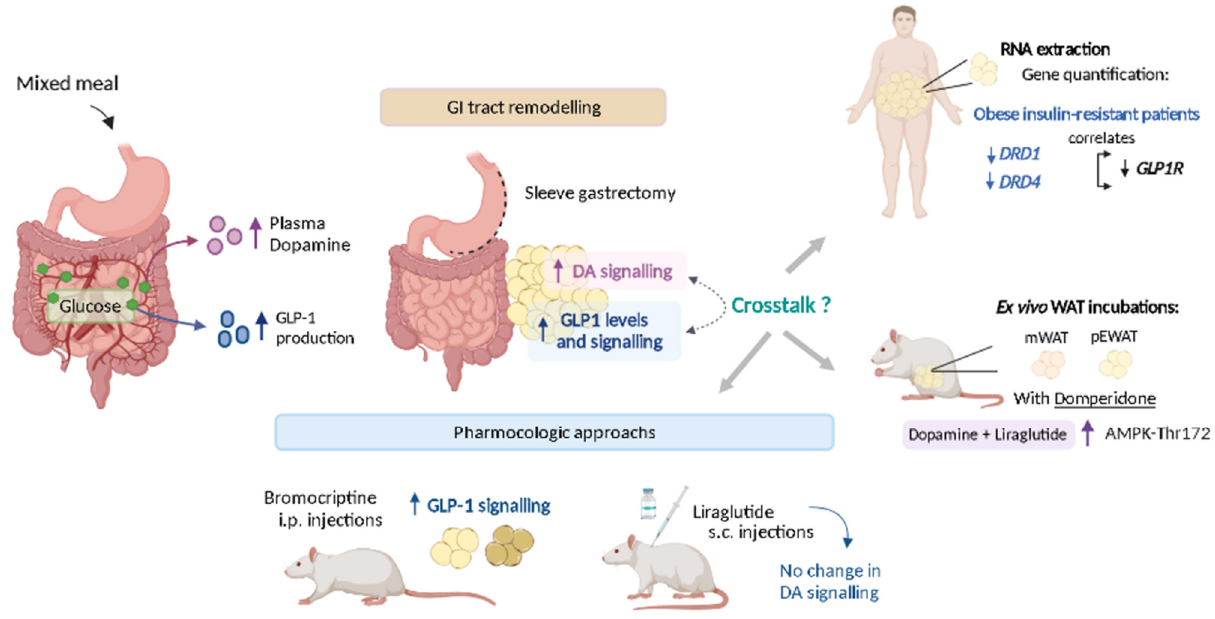
Figure 7. Summary figure of relevant findings. Plasma dopamine levels are postprandially elicited by dietary glucose, and its action in WAT is regulated by the gut. Dopaminergic signaling is corre- lated to GLP-1R in human adipose tissue and their signaling crosstalk regulates the catabolic activity of adipose tissue. Further, dopamine regulates GLP-1R levels in rat adipose tissue, but not the op- posite.